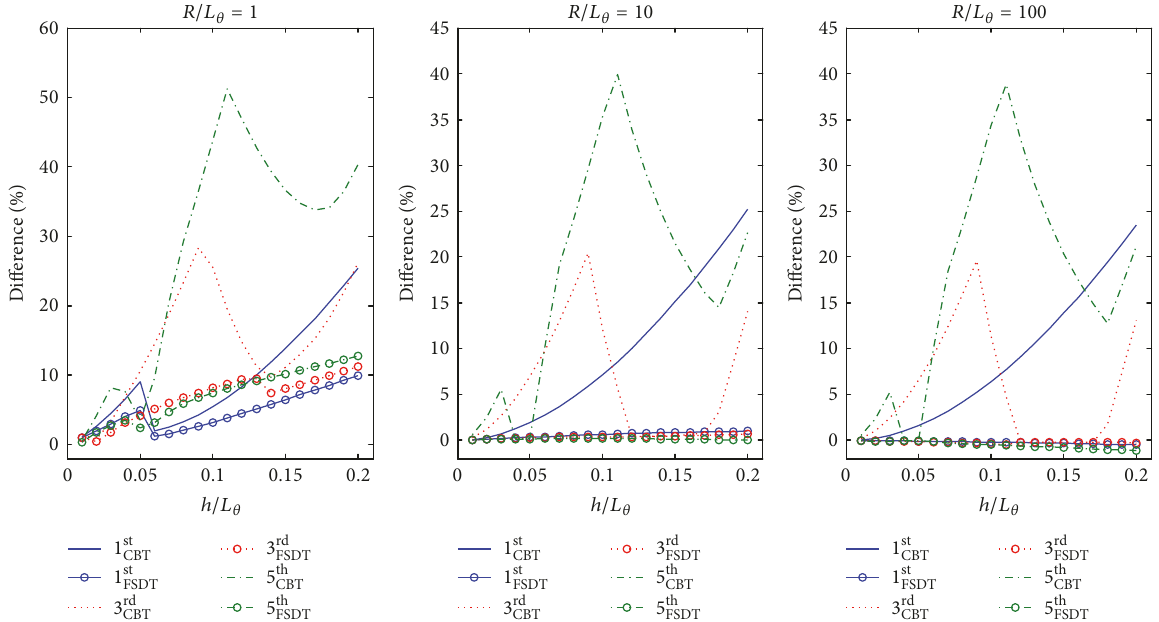
Figure 4: Relative deviations between frequency parameters Ω based on the CBT/FSDT theory models to those of 2D theory for circular beams with various thickness ratios (C-C boundary condition).